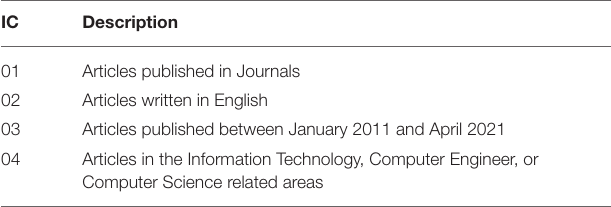
TABLE 2 | Inclusion criteria.